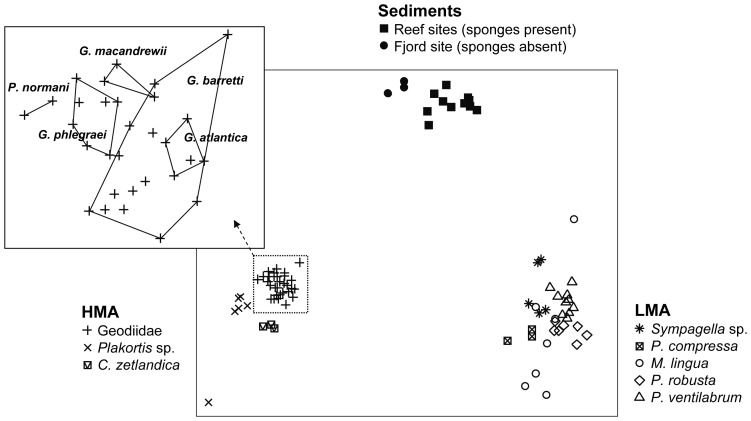
Overall bacterial community variation.The two-dimensional NMDS ordination (based on a Bray-Curtis dissimilarity matrix) of the multidimensional data in reduced space yielded a stress value of 0.11. Each symbol corresponds to one sediment sample or sponge specimen of a given species, with the respective PCR-triplicates already merged into a consensus profile per sample. Insert: Bacterial community variation for specimens from five species of the Geodiidae family.